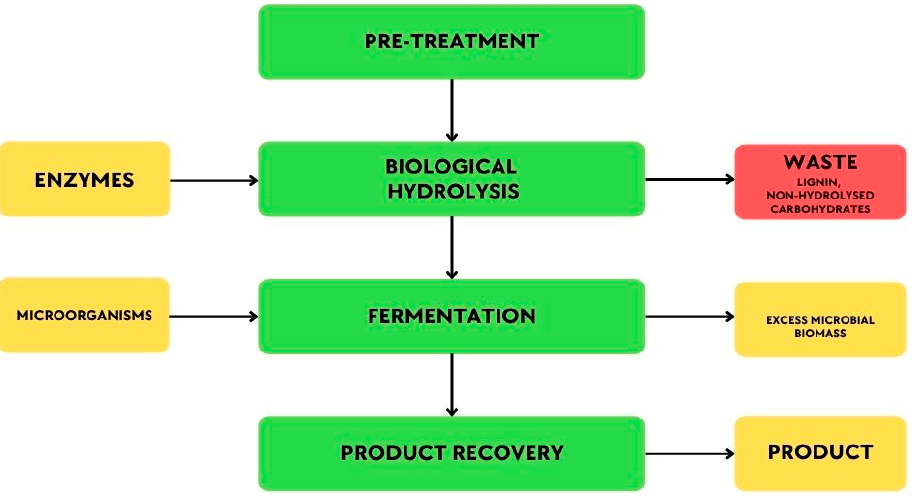
Figure 1. Biomass feedstock biological conversion process scheme with input and output of bio- based products.